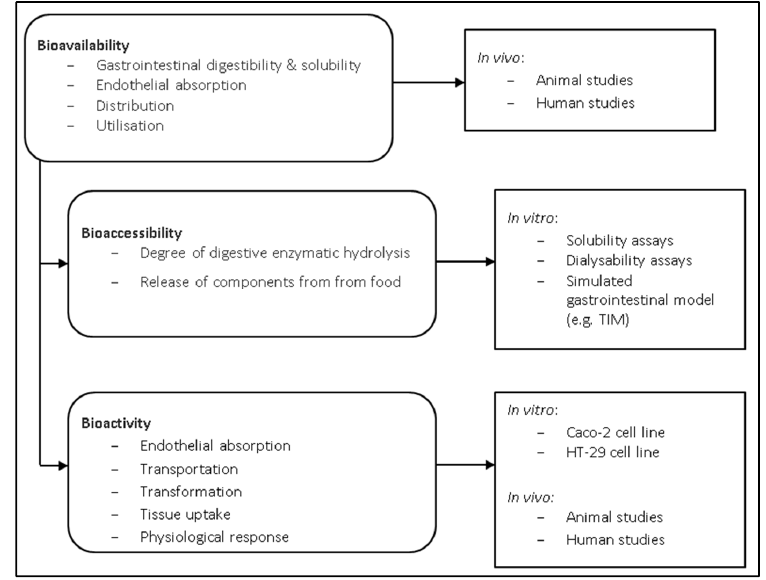
Figure 1. Schematic representation of digestion and methods that may be used to determine bioavailability, bio ‐ accessibility and bioactivity of proteins and other foods. Adapted from bioavailability, bio-accessibility and bioactivity of proteins and other foods. Adapted from Carbonell ‐ Capella et al. [47]. TIM: TNOASR’s intestinal model; TNOASR: The Netherlands Carbonell-Capella et al.